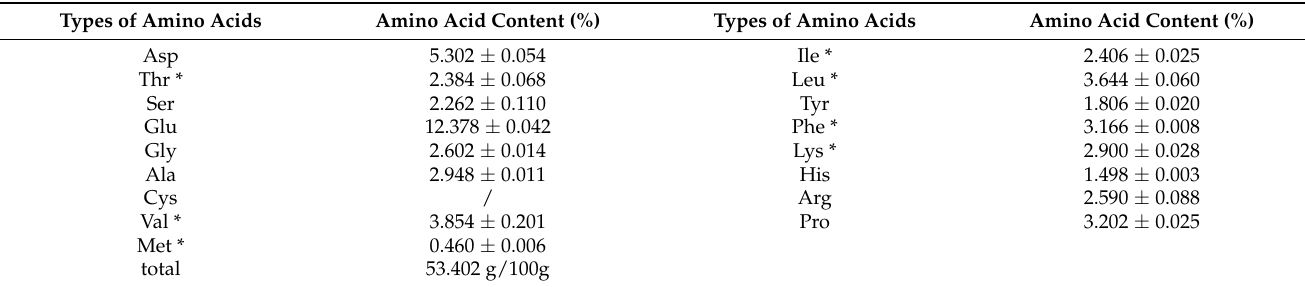
Figure 9. Content of SER powder and SEP. Table 6. Analysis results of SEP amino